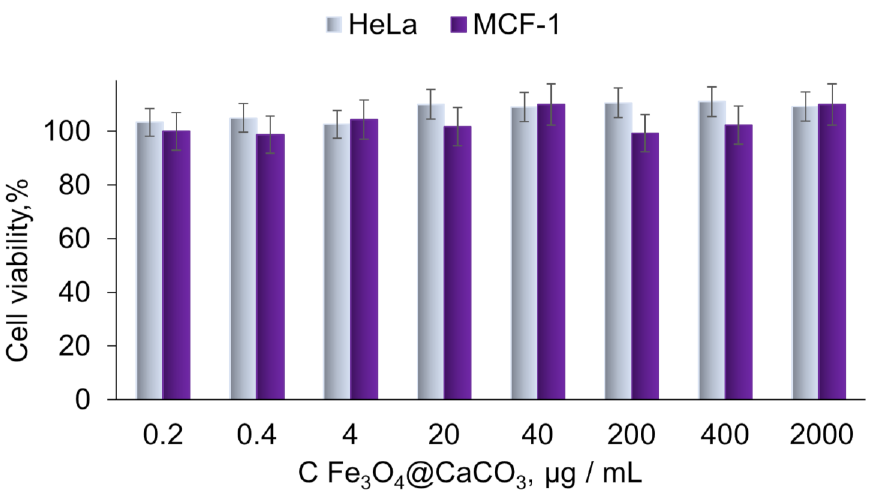
Figure 8. Cell viability assay using MTT. HeLa and MCF-7 cells were incubated with Fe 3 O 4 @CaCO 3 for 48